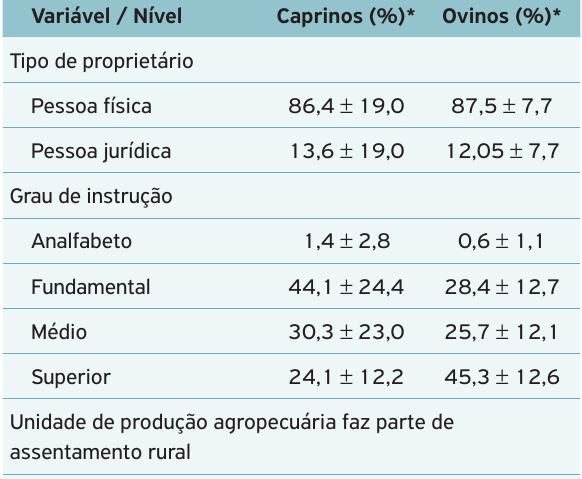
Tabela 4. Caprinocultura e ovinocultura: características do criador e da unidade de produção agropecuária, estado de São Paulo,